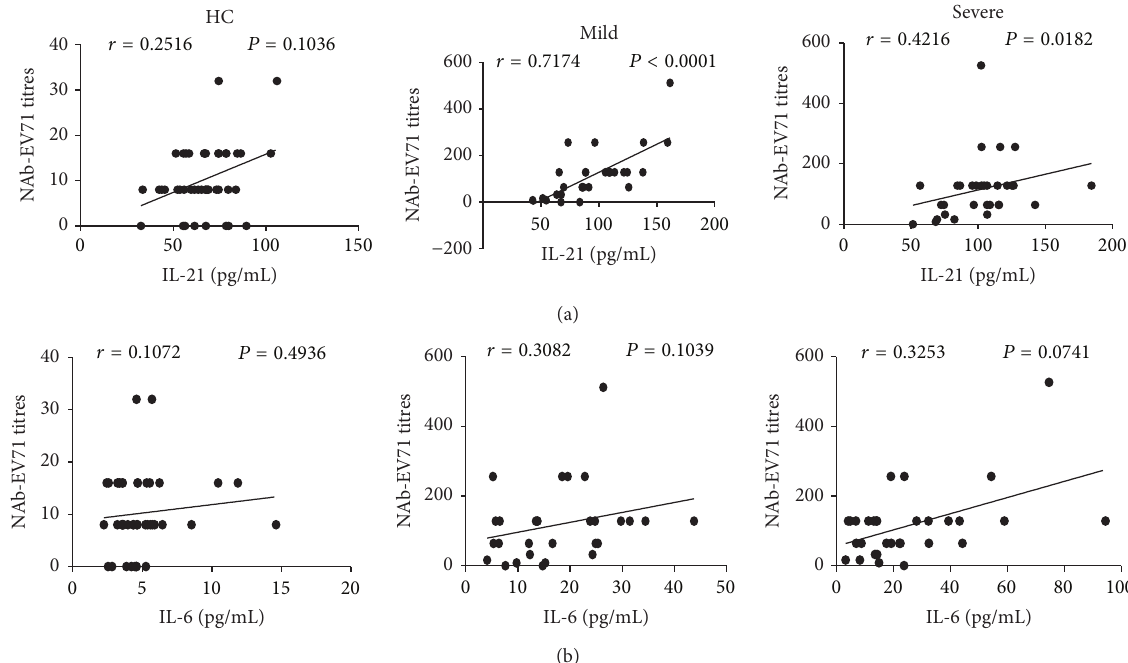
Figure 5: Correlation of specific NAb-EV71 titres and cytokines levels from HC and EV71-infected patients including mild and severe cases. (a) Relationship between the titres of specific NAb-EV71 and the serum levels of IL-21. (b) Relationship between the titres of specific NAb- EV71 and the serum levels of IL-6.